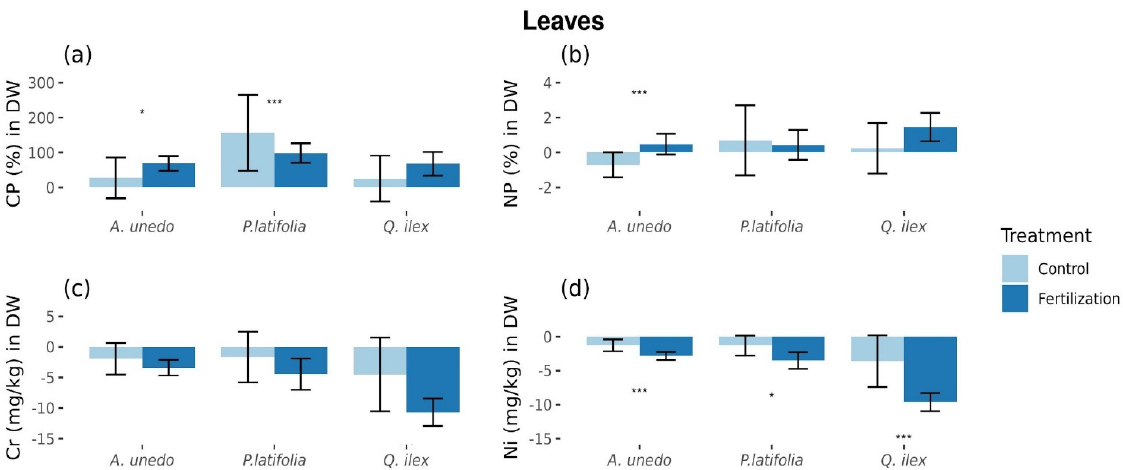
Figure 2. Foliar elemental ratios and microelements statistically different between control and fertilized plots. ( a ) C:P % in dry weight in leaves. ( b ) N:P % in dry weight in leaves. ( c ) Cr mg/kg in dry weight in leaves. ( d ) Ni mg/kg in dry weight in leaves. Values are relatives to original values in 2014 expressed in % of change. * = Marginal significance ( p = [0.05, 0.1]). *** = Significant differences ( p < 0.05). Figures with standard errors.